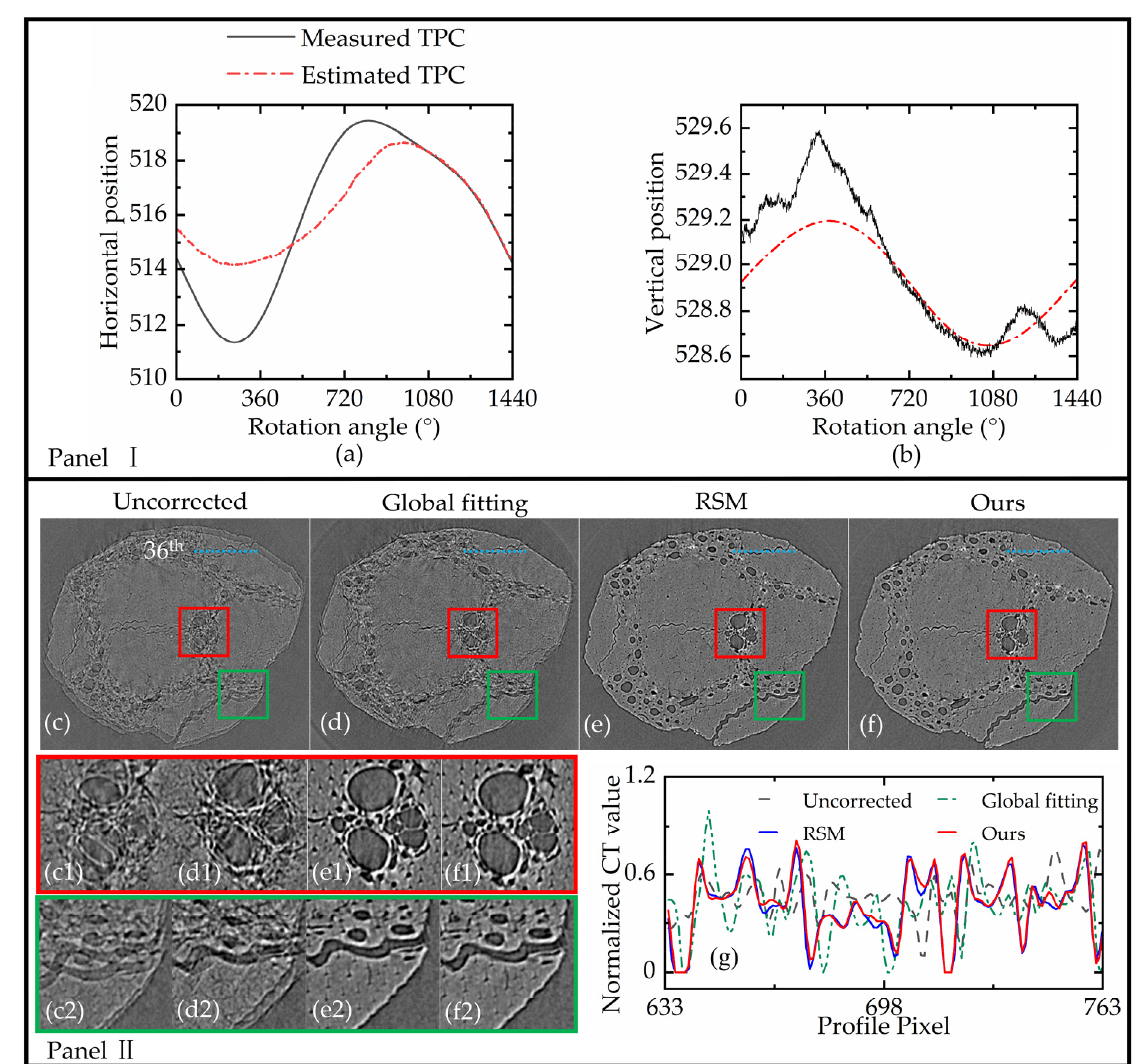
Figure 8. The experimental results of bamboo stick scanning. Panel I: Correction process of the bamboo stick; ( a ) H-TPC. ( b ) V-TPC; Panel II: Slices of the bamboo stick; ( c1 , d1 , e1 , f1 ) magnified images of the red region in the first line of slices; ( c2 , d2 , e2 , f2 ) magnified images of the green region in the first line of slices; ( g ) profile of the bamboo stick slice marked with a blue line in ( c ) to ( f ).